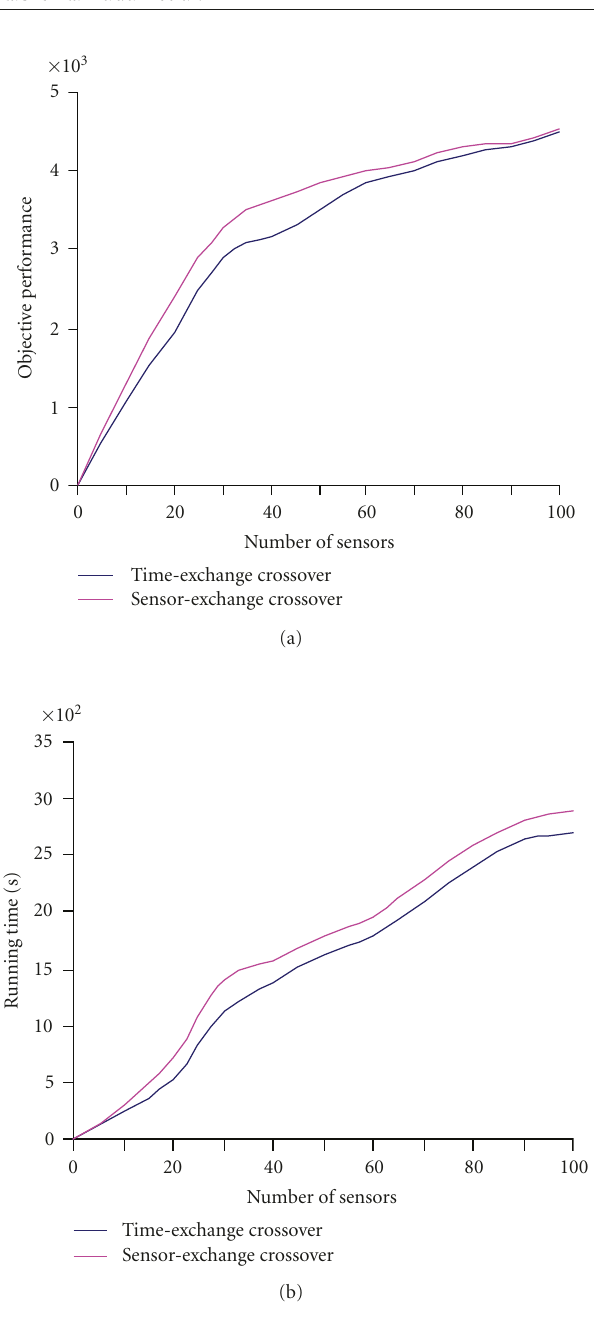
Figure 9: A comparison between time-exchange and sensor- exchange crossover operators performance with increasing number of sensors: (a) objective performance and (b) running time.